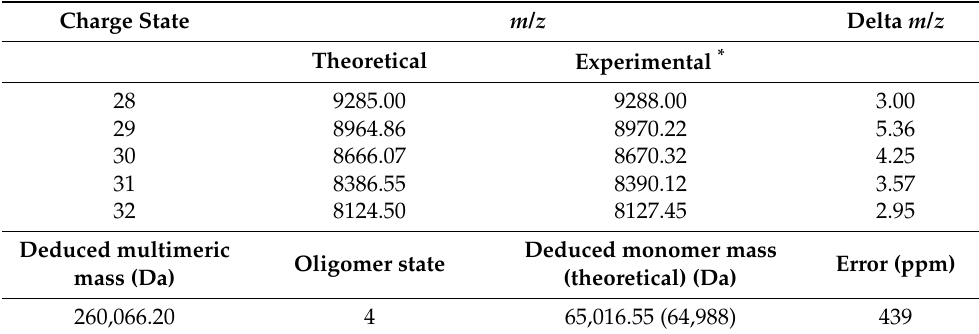
Table 1. Molecular mass and oligomeric state of the full-length tp ι -CA determined by ESI-MS.